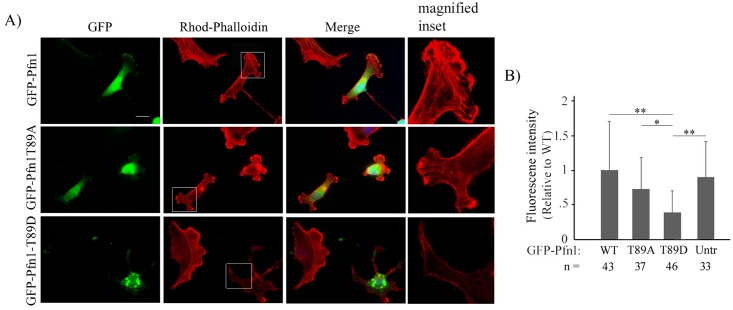
Overexpression of T89D-Pfn1 has a robust effect on actin cytoskeleton in MDA-231 cells.A) Fluorescence images of MDA-231 cells expressing indicated EGFP-fused Pfn1 constructs and stained with rhodamine-phallodin staining. Scale bar represents 20 μm. B) A bar graph summarizing the average rhodamine-phalloidin fluorescence intensity/cell for T89A-Pfn1 and T89D-Pfn1 expressors relative to that of WT-Pfn1 expressing and untransfected cells. ‘N’ indicates number of cells analyzed for each group pooled from 3 independent experiments (** indicates p < .01; * indicates p < .05).